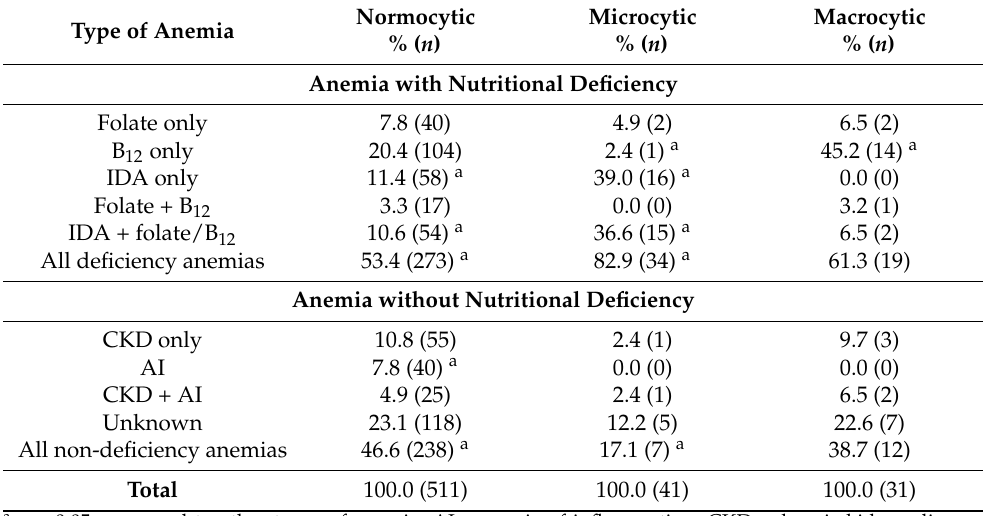
Table 3. Normo-, micro-, and macrocytosis in definite types of anemia (classified according to receiver operating characteristic analysis) in the PolSenior study.